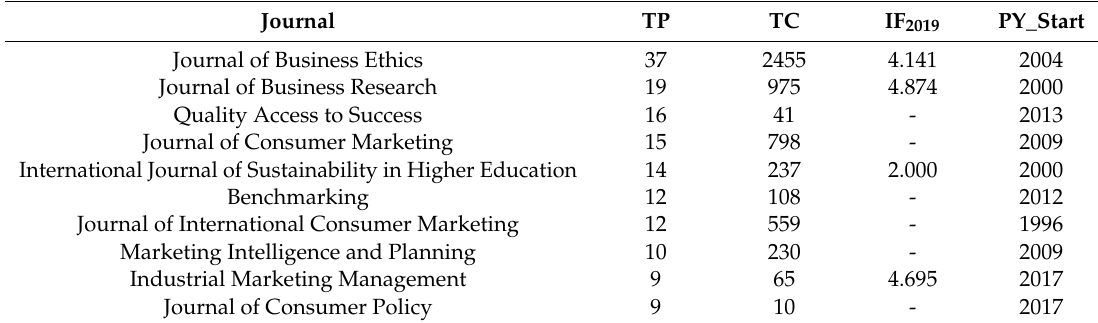
Table 4. Most productive journals in the field of green